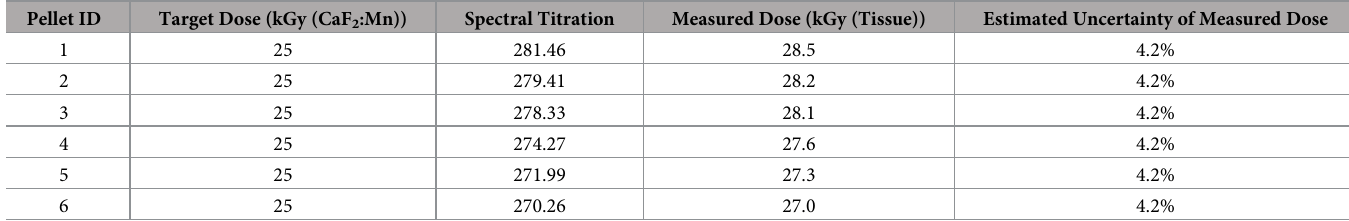
Table 1. Alanine dosimetry measurements.